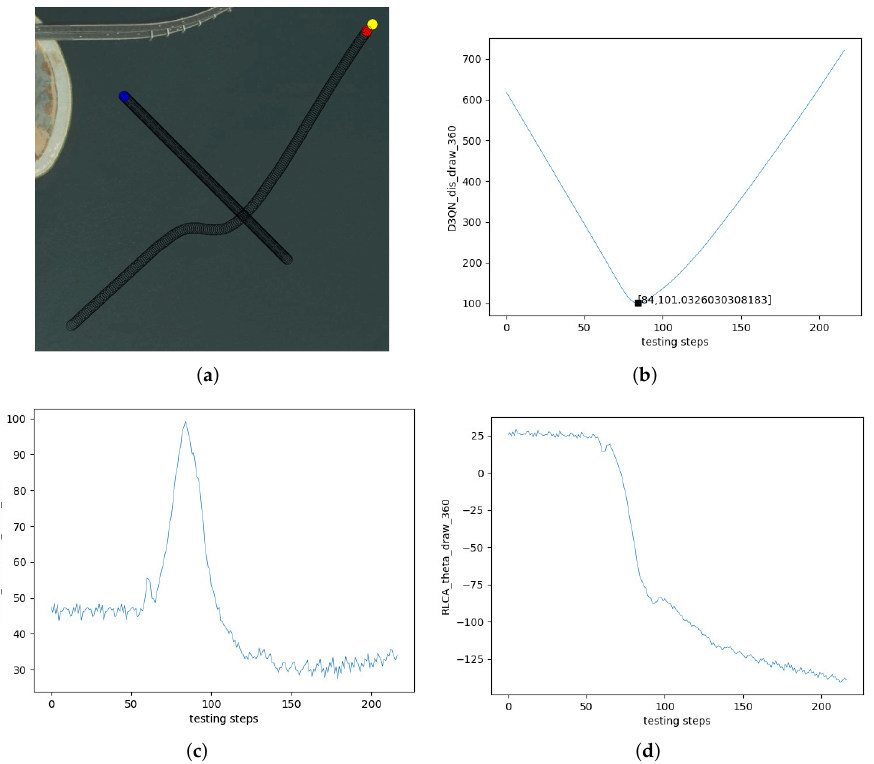
Figure 19. Test effect of Cross Encounter 2. ( a ) Crossing. ( b ) The distance between two USVs. ( c ) The course of the own USV. ( d ) θ of the own